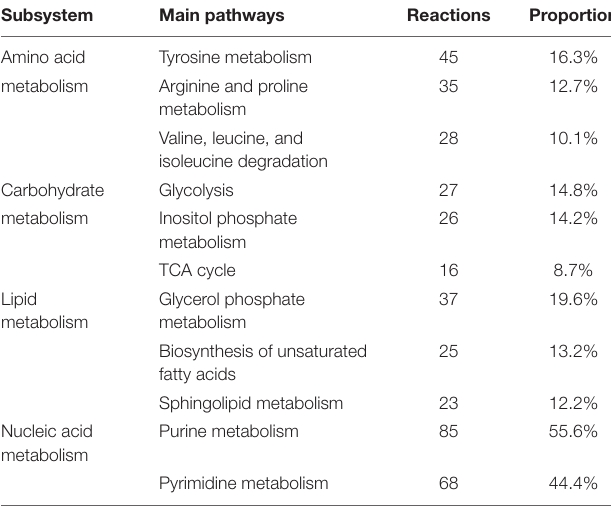
TABLE 5 | The main pathways in different metabolic